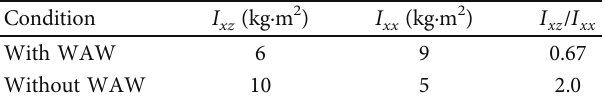
Table 3: E ff ect of mass properties with and without the WAW.